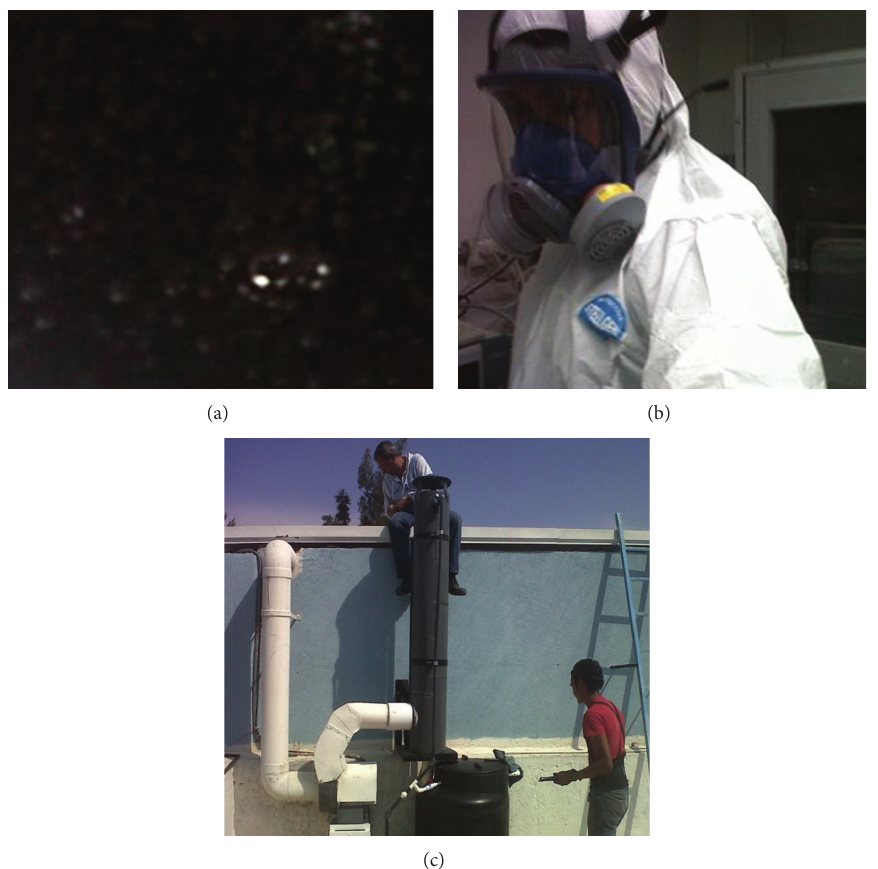
Figure 1: Handling and control of (a) spent caustics mixture, (b) safety equipment, and (c) specialized infrastructure.